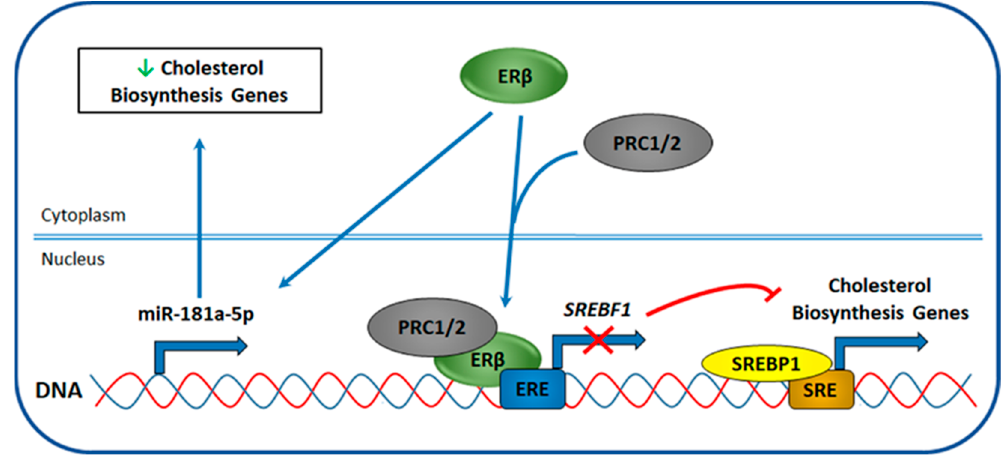
Figure 6. Proposed mechanism of ER β‐ mediated regulation of cholesterol biosynthesis in TNBC. ER β interacts with chromatin repressive complexes, e.g., polycomb repressive complexes 1 and 2 (PRC1/2), binds to ERE present in sterol regulatory element binding factor 1 (SREBF1) gene promoter and inhibits SREBF1 expression. SREBF1 gene encodes for sterol regulatory element binding protein 1 (SREBP1), which drives expression of cholesterol biosynthesis genes by binding to sterol regulatory elements (SREs) present in their promoters. Inhibition of SREBF1 transcription reduces expression of SREBP1 ‐ driven genes leading to the downregulation of cholesterol biosynthesis. Alternatively, ER β by unknown mechanism induces expression of miR ‐ 181a ‐ 5p, which targets cholesterol biosynthesis genes and regulates their expression post ‐ transcriptionally.